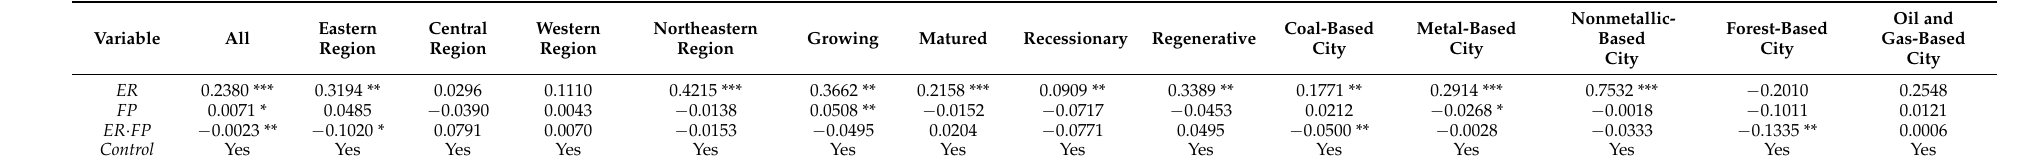
Table 7. Tobit regression test